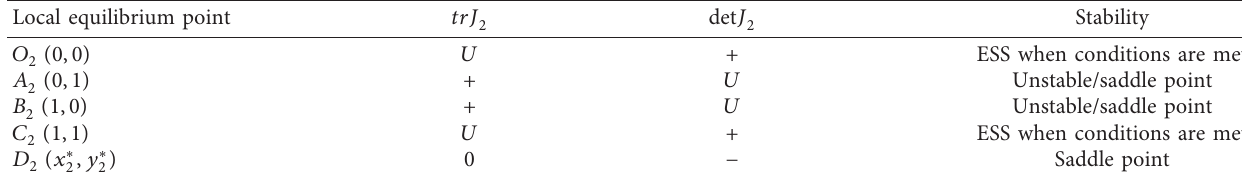
Table 4: Stability analysis of local equilibrium point of system with government